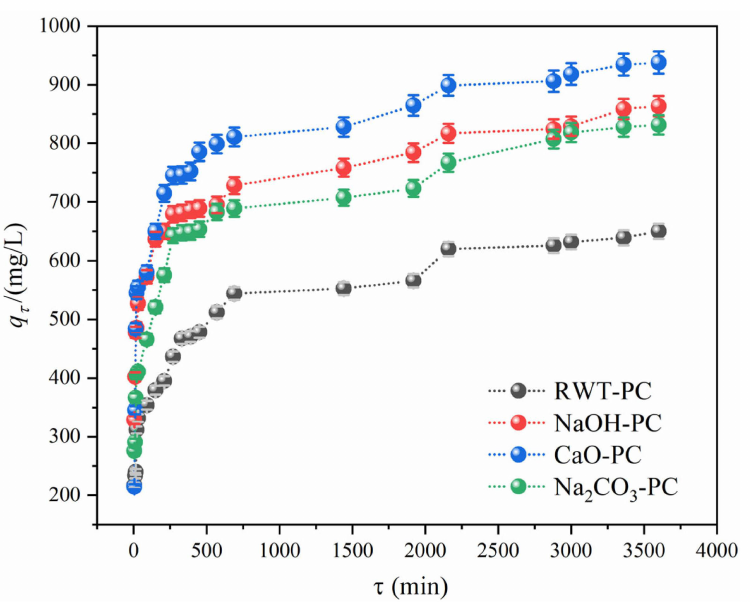
Figure 6. Effect of contact time on MG dye adsorption capacity (Dosage = 40 mg, MG concentration = 1000 mg/L, and T = 301